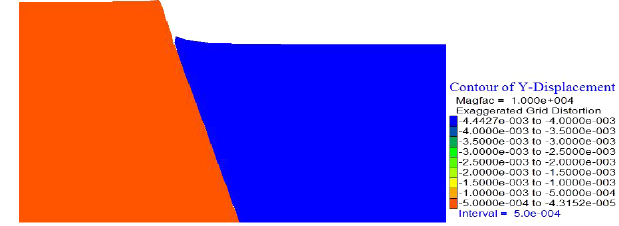
Figure 4. The annual settlement in scheme 1 (scaled up to 10000 times of the original.